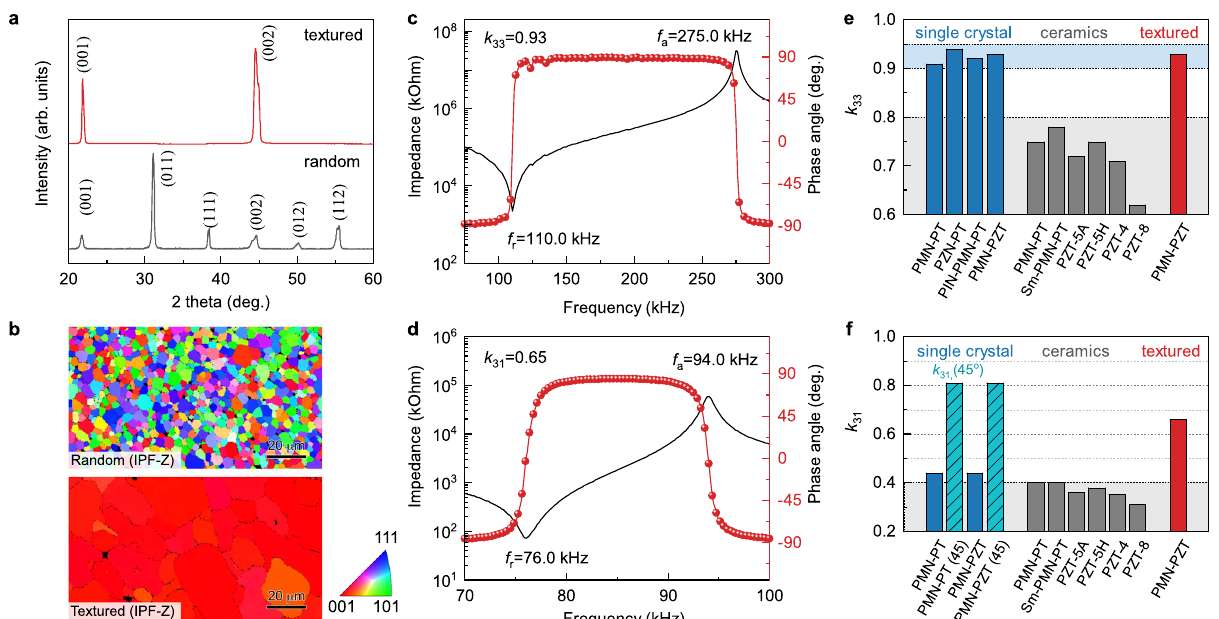
Fig. 3 Textured PMN-PZT ceramics. a XRD patterns of random and textured PMN-PZT ceramics. b EBSD images of random and <001> textured PMN- PZT ceramics. c Impedance spectra of <001> textured PMN-PZT ceramics in longitudinal 33 mode, the electromechanical coupling factor, k 33 , is as high as 0.93. d Impedance spectra of <001> textured PMN-PZT ceramics in transverse 31 mode, the electromechanical coupling factor, k 31 , is as high as 0.65. e Comparison of k 33 among [001] oriented single crystals, random ceramics and <001> textured ceramics. f Comparison of k 31 among [001] oriented single crystals, random ceramics and <001> textured ceramics. Here k 31 (45 o ) is the k 31 of [001] oriented single crystal sample with 45 o cut, where the orientations of the sides are [110], [ (cid:1) 110] and [001], respectively. The references for k 33 and k 31 data for single crystals and ceramics in e , f can be found in Supplementary Note 1.